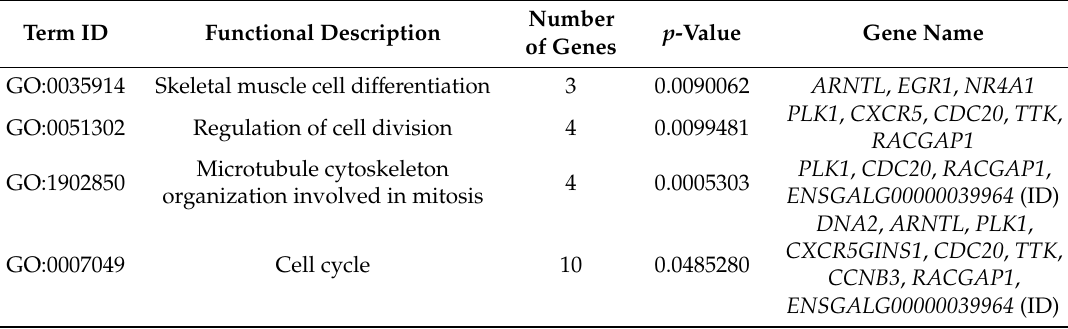
Table 6. The significantly enriched biological process terms for the four-week-old